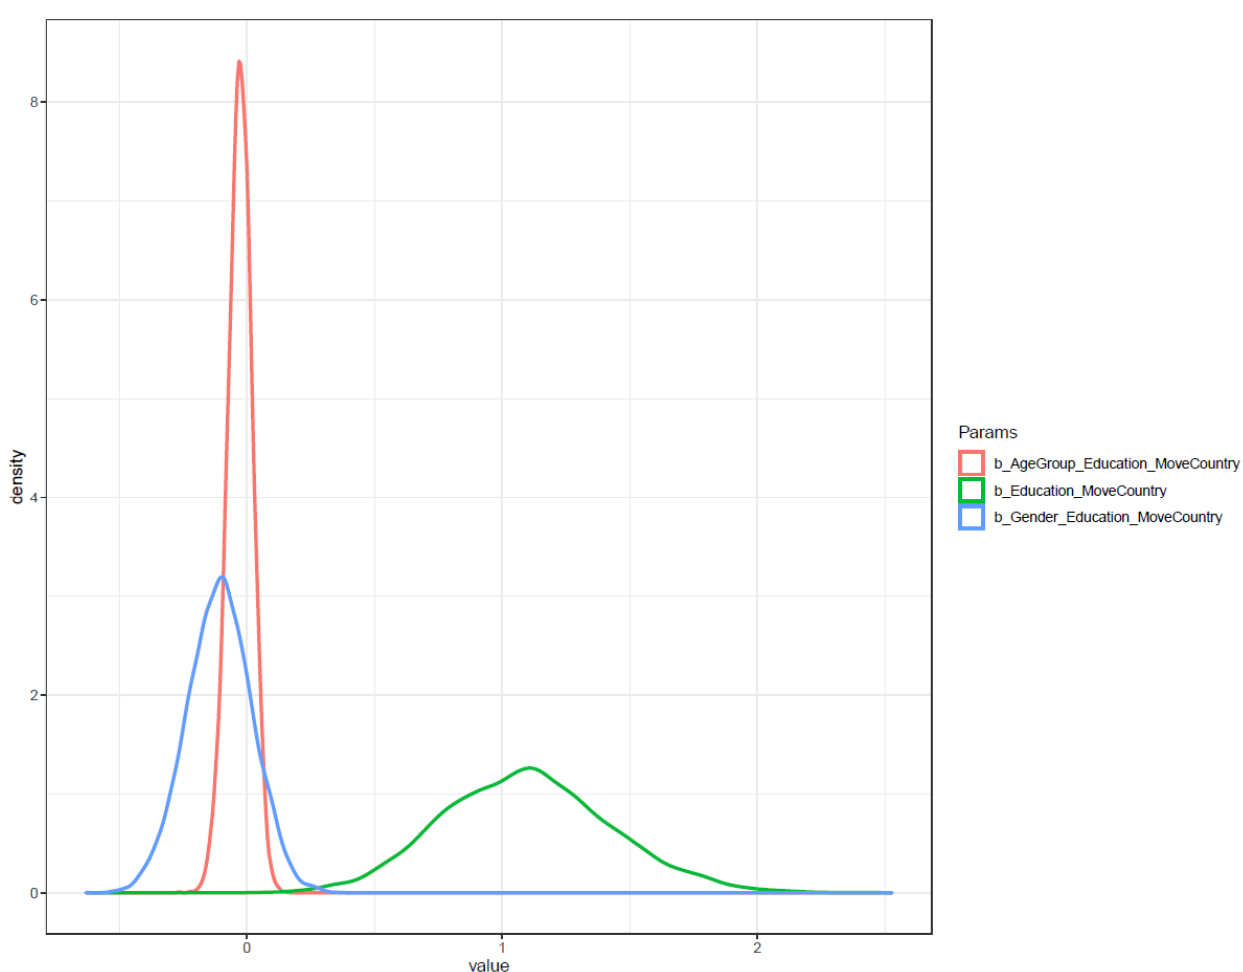
Figure 10. Distributions of Model 2′s posterior coefficients with uninformative priors on a density plot.